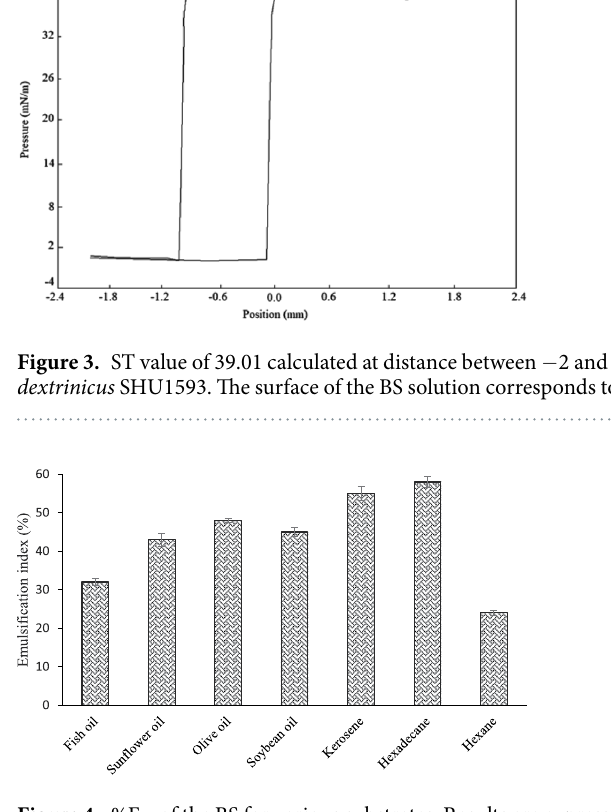
Figure 4. %E 24 of the BS for various substrates. Results are expressed as mean ± standard deviations of values from triplicate